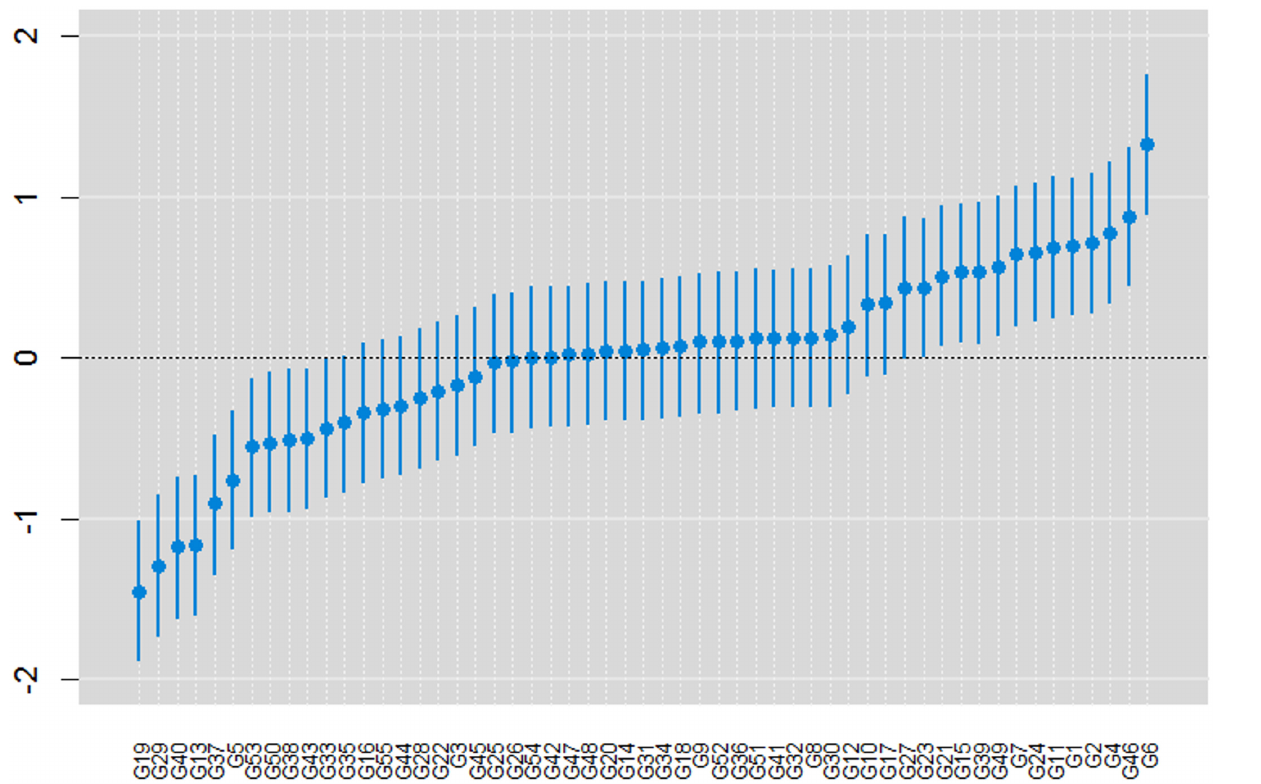
Fig 8. Posterior means and the 95% HPD intervals for the genotype effects.